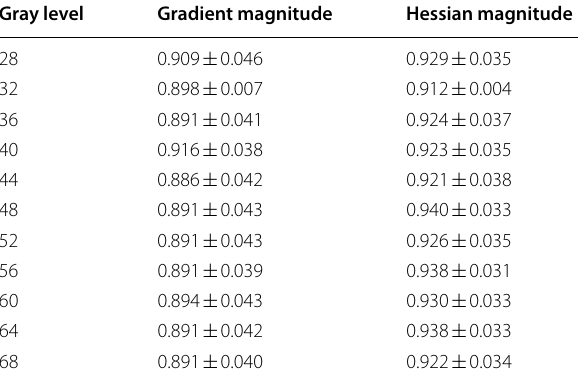
Table 3 AUC scores of gradient magnitude and Hessian magnitude under different gray levels while the t -th root is set to be 2 Gray level